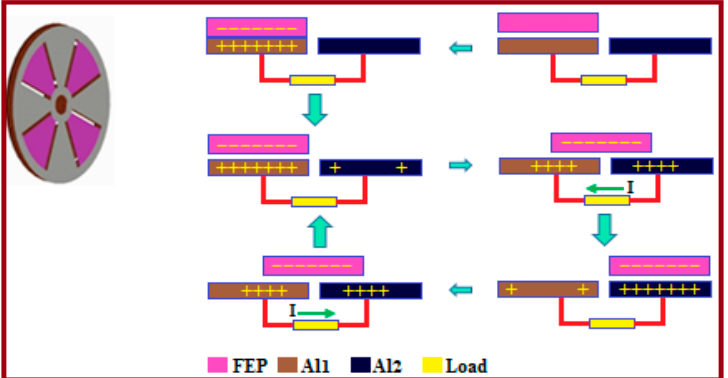
Figure 4. Schematic diagram of the working mechanism of the TENG based on the rotation of the FEP on the aluminum electrodes.